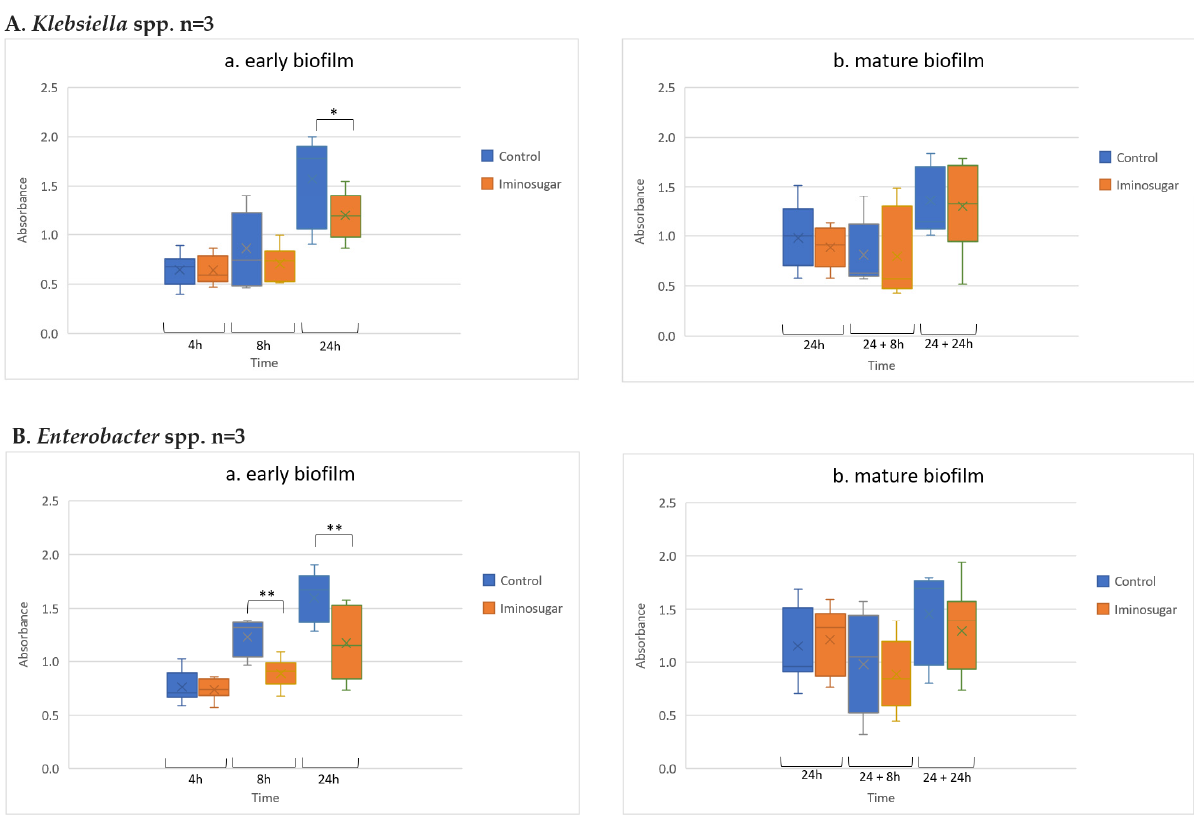
Figure 2. Effect of iminosugar PDIA on biofilm production by selected Gram-negative Enterobacteriaceae . ( A ), Klebsiella spp., ( B ), and Enterobacter spp. in ( a ) early biofilm and ( b ) mature biofilm. n refers to the number of strains. The figure represents biofilm absorbance readings for all strains belonging to a given species at a given time (measurements for each strain were performed in triplicates). Biofilm production expressed as absorbance ( λ = 492 nm) after Congo red staining at different time points. * p < 0.05 and ** p <